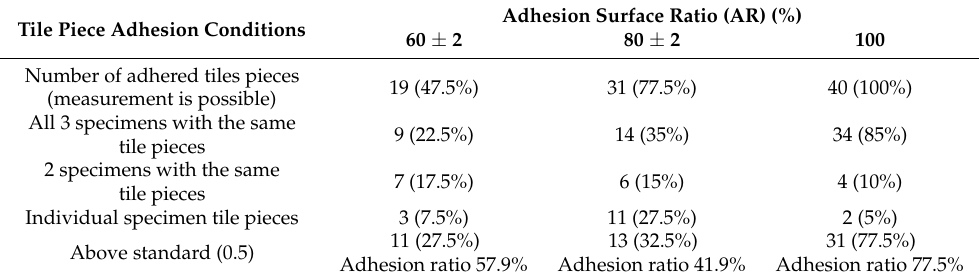
Table 6. Overall adhesion analysis report for specimens of respective AR.